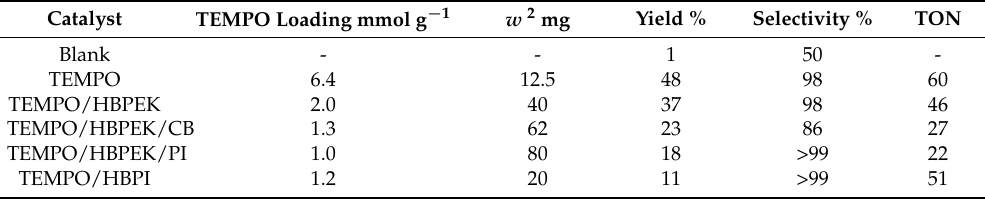
Table 2. Results of aerobic oxidation of benzyl alcohol to benzaldehyde 1 [27,43]. Catalyst